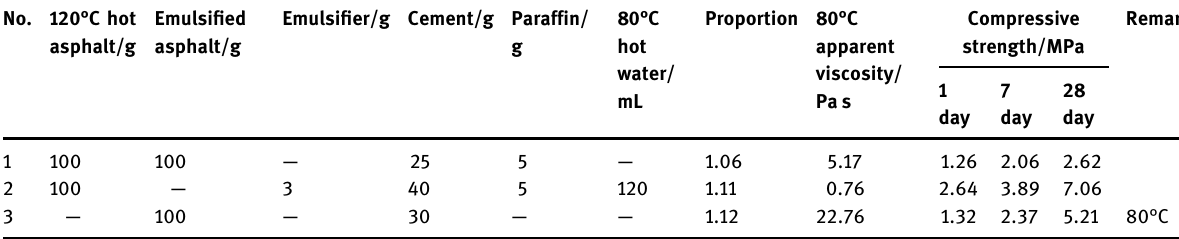
Table 2: Proportion and performance indicators of low - thermal asphalt No. 120°C hot